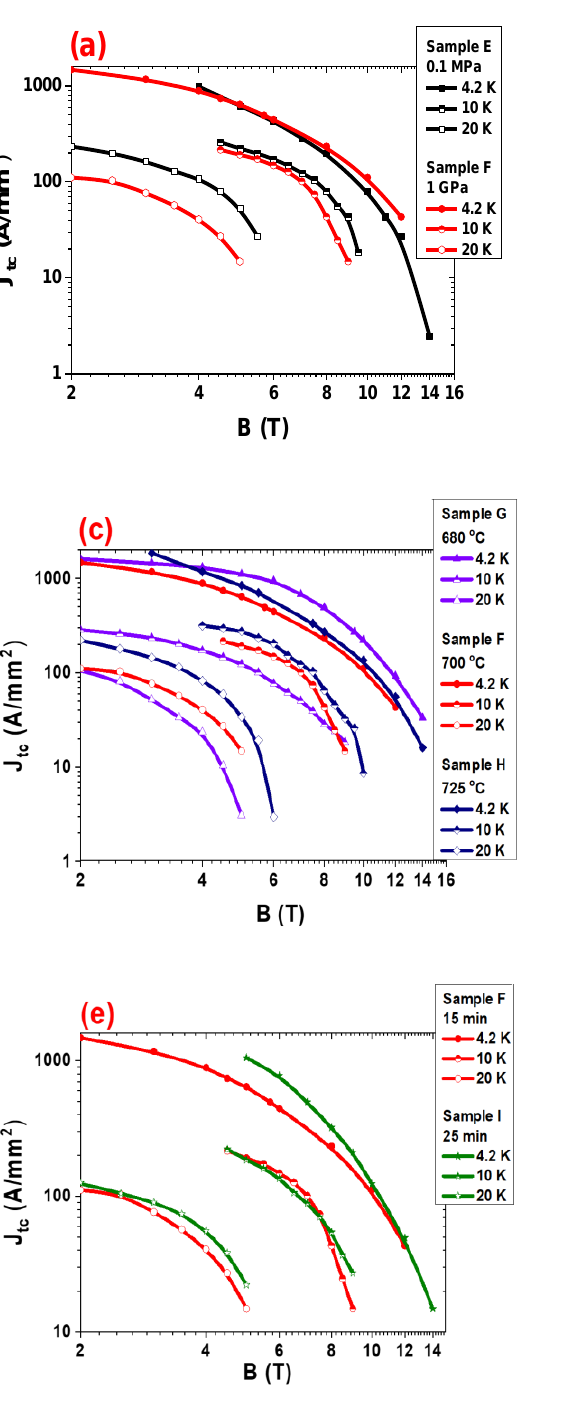
Figure 7. ( a , c , e ) The transport critical current density ( J tc ) as a function of the perpendicular magnetic field ( B ) at 4.2 K, 10 K, and 20 K for SiC doped MgB 2 wires with a 0.83 mm diameter. ( b , d , f ) The reduced pinning force depending on the reduced magnetic fields for SiC doped MgB 2 wires.